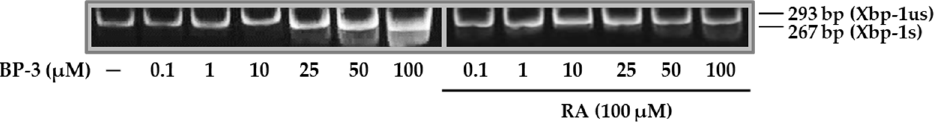
Figure 6. The influence of benzophenone-3 (BP-3) alone and in combination with rosmarinic acid (RA) on the expression of decorin at the mRNA ( a ) and protein ( b ) levels in fibroblasts. The expression of decorin ( DCN ) gene was assayed by